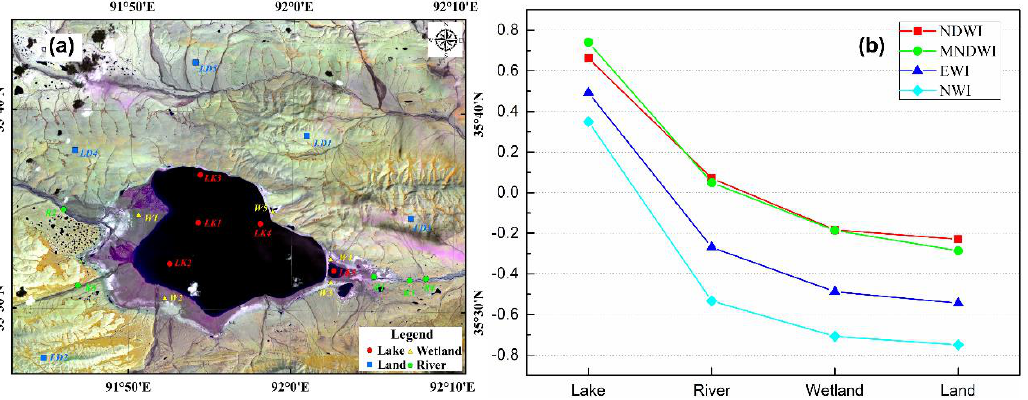
Figure 2. Comparison of several water body indices around Zonag Lake: ( a ) Selection of different features and ( b ) comparison of different water index.